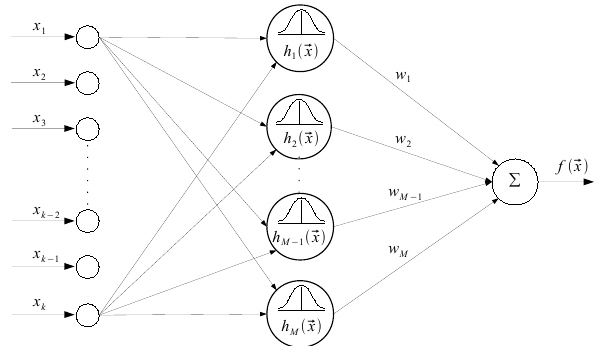
Fig. 2. Radial basis function network architecture for function ap- Fig. 2. Radial Basis Function Network architecture for function approximation.